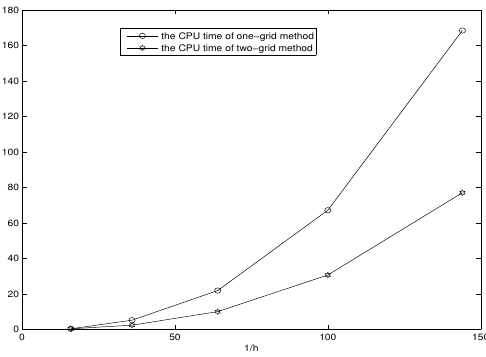
Figure 4. CPU time analysis using one- and two-grid